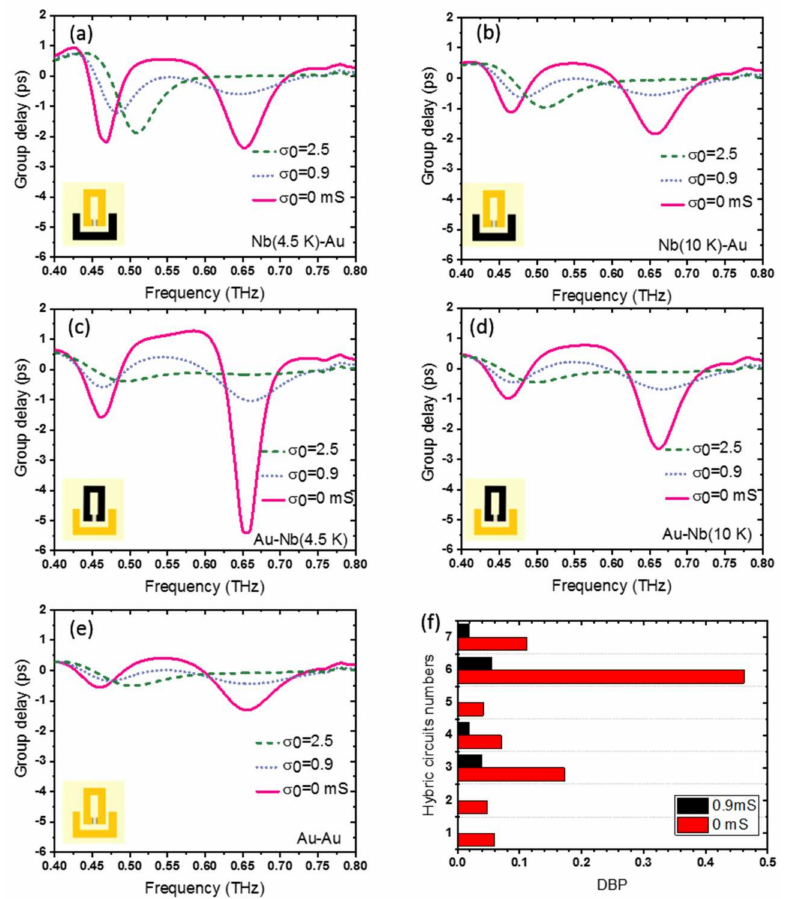
Figure 10. Group delay through the hybrid photonic integrated circuit for different graphene conductivity when the bright/dark resonators are set to be ( a ) Nb (at T = 4.5K)/Au and ( b ) Nb (at 10K)/Au. The same information is given in ( c , d ) but with Nb and Au replaced in the SRR unit-cells. Insets show one unit-cell, where Nb SRR is shown in black, and Au SRR is shown in yellow. ( e ) Group delay through the hybrid photonic integrated circuit for different graphene conductivity when the bright/dark resonators are both set as Au. ( f ) delay-bandwidth product of hybrid device bright/dark resonators for device # 1-Nb (at T = 4.5 K)/Au, 2-Nb (at T = 10 K)/Au, 3-Au/Nb (at T = 4.5 K), 4-Au/Nb (at T = 10 K), 5-Au/Au, 6-Nb (at T = 4.5 K)/Nb (at T = 4.5 K), 7-Nb (at T = 10 K)/Nb (at T = 10 K), at σ 0 = 0 mS and σ 0 = 0.9